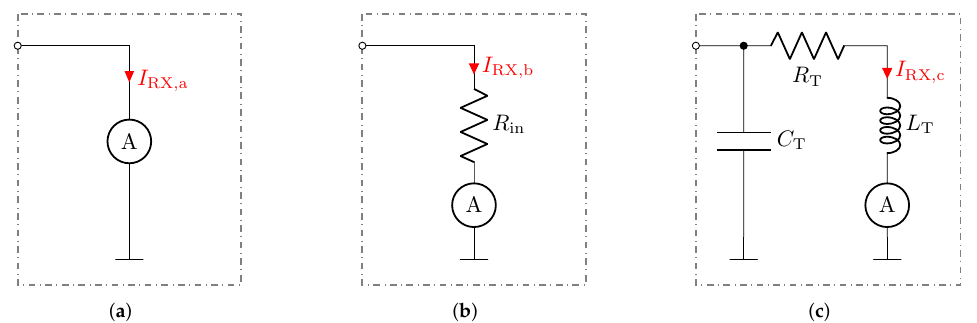
Figure 4. Illustration of three received current measurement circuits, applicable for the circuit shown in Figure 3. ( a ) Low-Z measurement circuit with an idealized input resistance equal to zero. ( b ) Matched measurement circuit, by means of maintaining a desired input resistance R in . ( c ) LCR measurement circuit. The resonance circuitry also provides filter